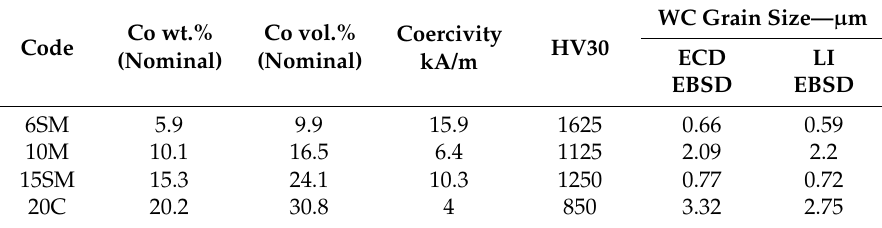
Table 1. Raw Material data for samples